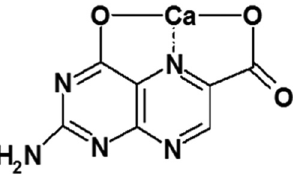
Figure 1: Active ingredient Immunopterin ( calcium pterin - 6 - carbox - ylate chelate ) [ 9 ]